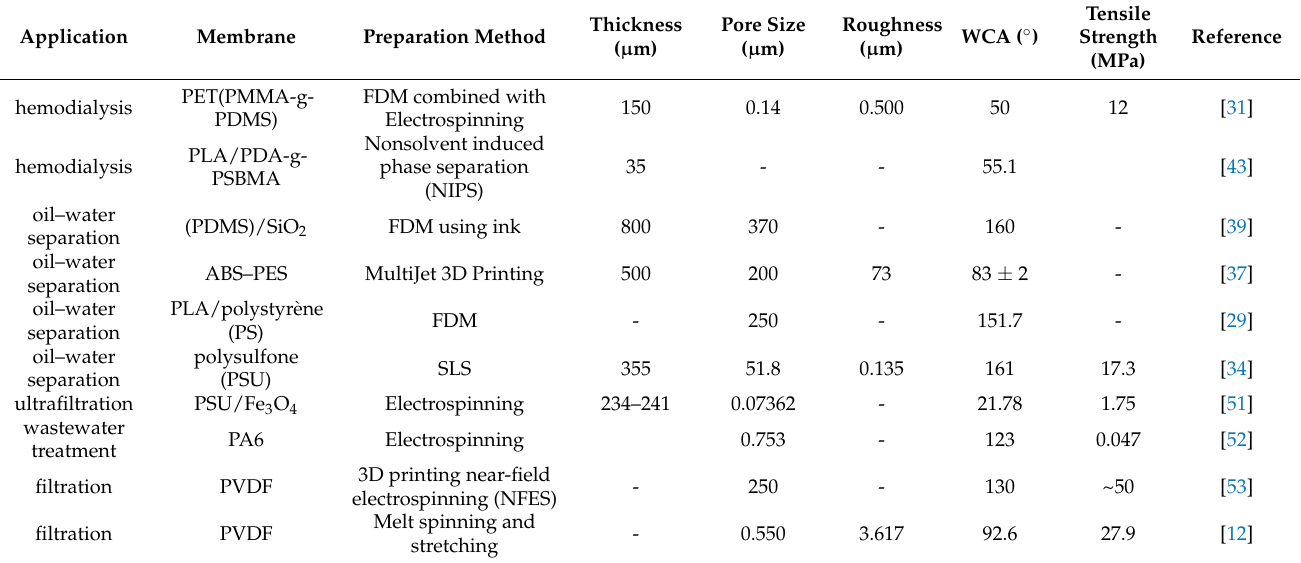
Table 1. Properties of 3D-printed membranes compared with conventional